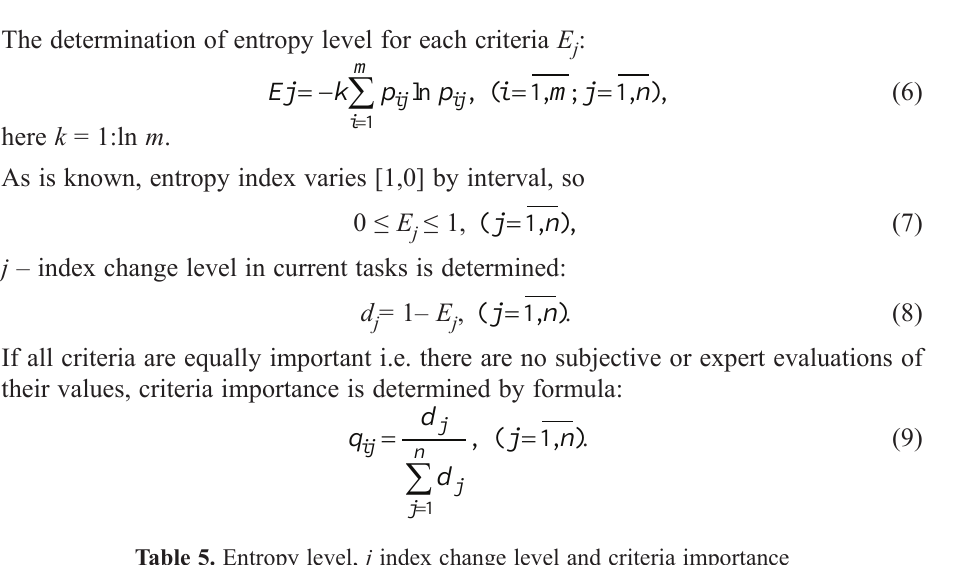
Table 5. Entropy level, j index change level and criteria